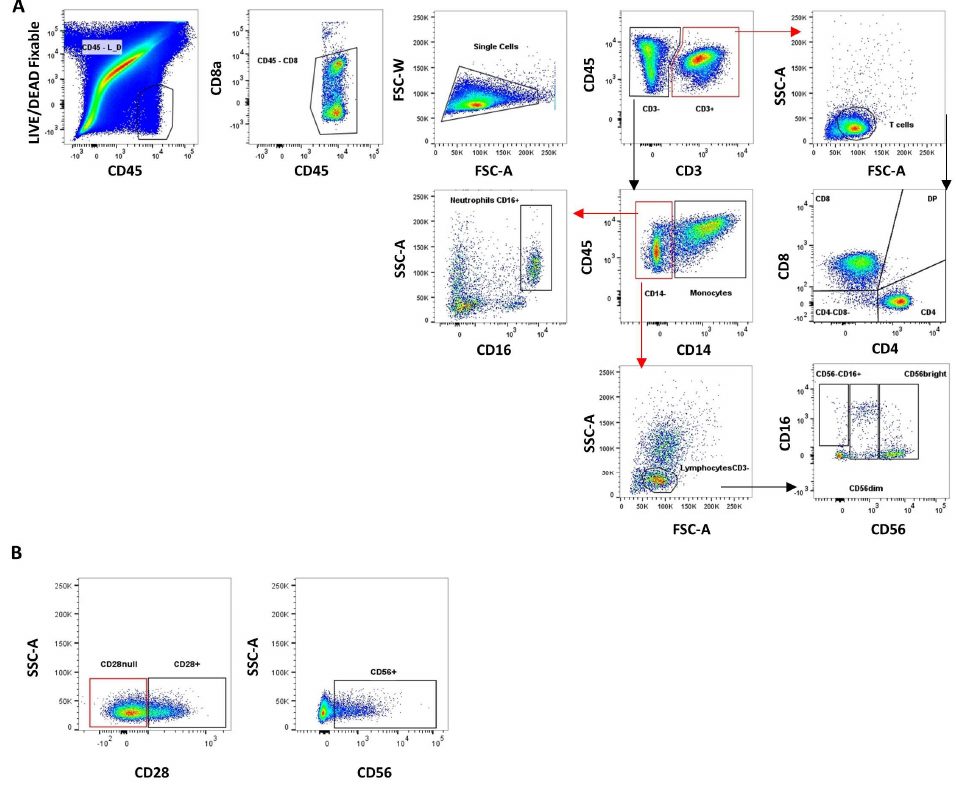
Figure 1. Gating strategy for aortic valve infiltrate. ( A ) After cleaning strategy, CD3+ cells and CD3 − cells were gated in a CD3 vs. CD45 plot. From the CD3+ gate, any remaining debris was excluded an SSC-A vs. FSC-A plot. Then CD4+, CD8+, CD4 − CD8 − , and CD4+CD8+ (DP) T cell subsets were determined in a CD8 vs. CD4 plot. From the CD3 − gate, monocytes (CD14+) and CD14 − cells were gated in an SSC-A vs. CD14 plot. From the CD14 − gate, CD16+ neutrophils were gated in an SSC-A vs. CD16 plot, and CD3 − lymphocytes were gated in an SSC-A vs. FSC-A plot. Finally, from CD3 − lymphocytes gate, NK cells and their subsets were defined confronting CD56 vs. CD16. ( B ) From CD4+, CD8+, and CD4 − CD8 − T cells, CD28 and CD56 gate were set by confronting SSC-A vs. CD28 or